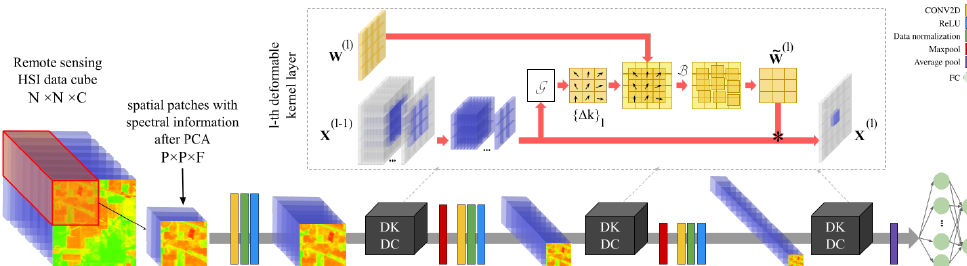
Figure 4. Graphical overview of the proposed adaptable network architecture. Standard convolu- tions have been implemented as point-wise CONV2D layers. Focusing on DK layers, a kernel scope W ( l ) ∈ R K ( l − 1 ) × M (cid:48) × M (cid:48) × K ( l ) is considered. Then, the generator G (implemented as a CONV2D) com- putes the kernel offsets { ∆ k l } from input X ( l − 1 ) . The bilinear sampler B samples a new set of kernels ˜ W ( l ) from W ( l ) and { ∆ k } , which is convolved over the input as a depth-wise layer, obtaining the l output volume X ( l )